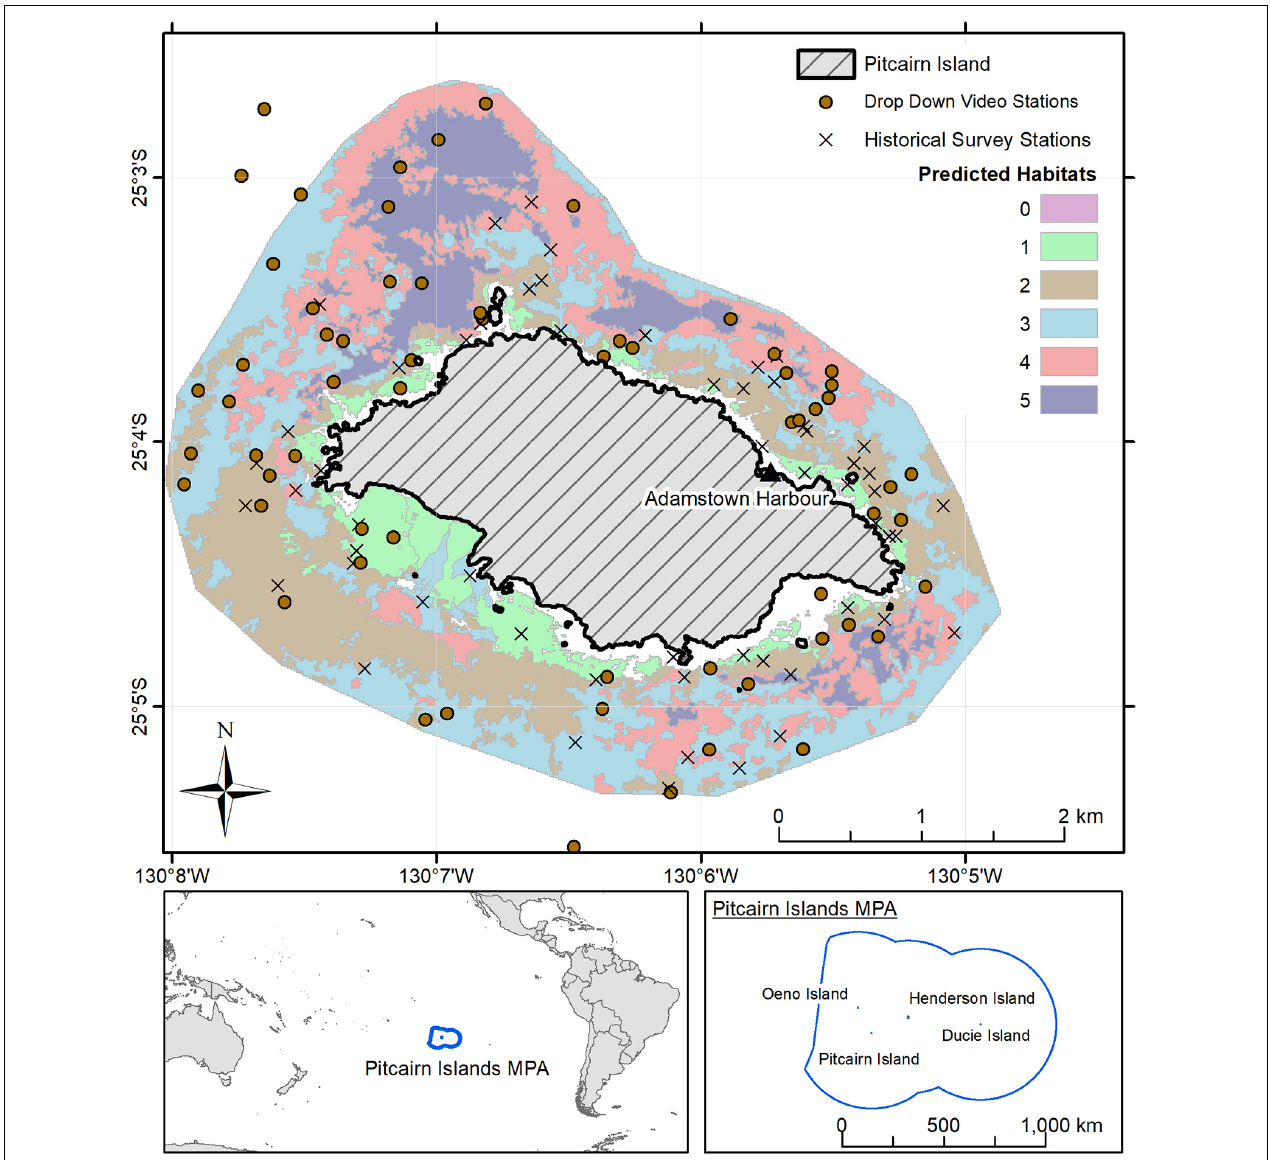
FIGURE 1 | Sampling locations around Pitcairn Island based on a random stratified design using the unsupervised classification of Sentinel 2A multispectral data as the units. The different colored areas represent the six predicted habitats/classes (0–5) which were grouped based on similar spectral properties of the blue